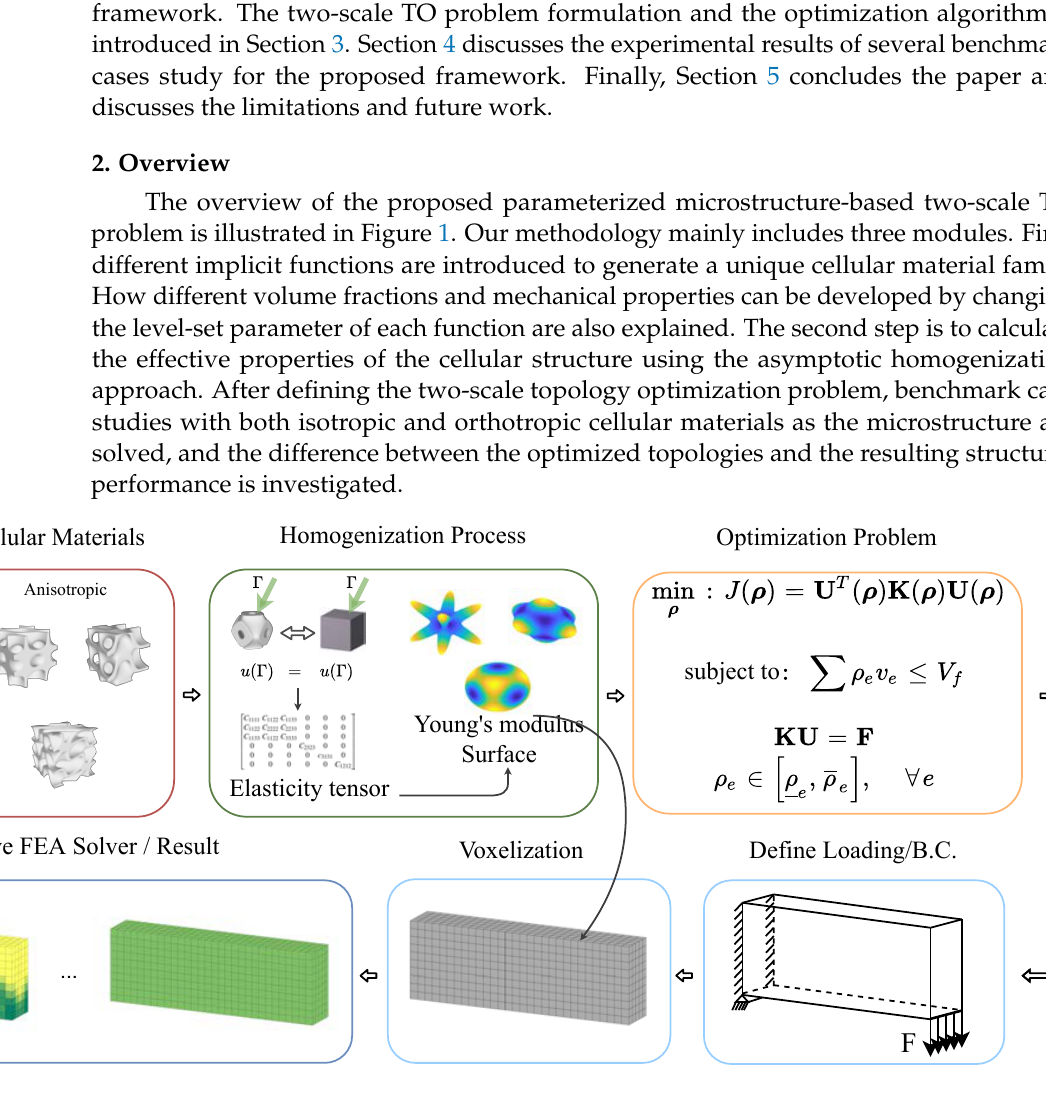
Figure 1. Flowchart of structural design optimization with isotropic/orthotropic